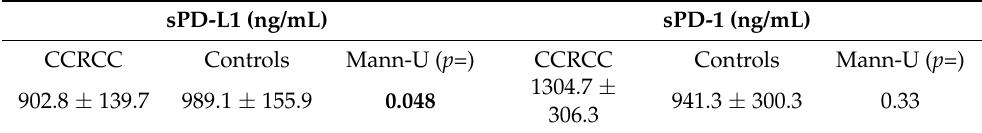
Table 1. sPD-L1 and sPD-1 levels in plasma samples from clear cell renal cell carcinoma (CCRCC) patients and healthy controls. Values are means ± standard errors. Significant p value in bold. sPD-L1 (ng/mL) sPD-1 (ng/mL) CCRCC Controls Mann-U ( p =) CCRCC Controls Mann-U ( p =)